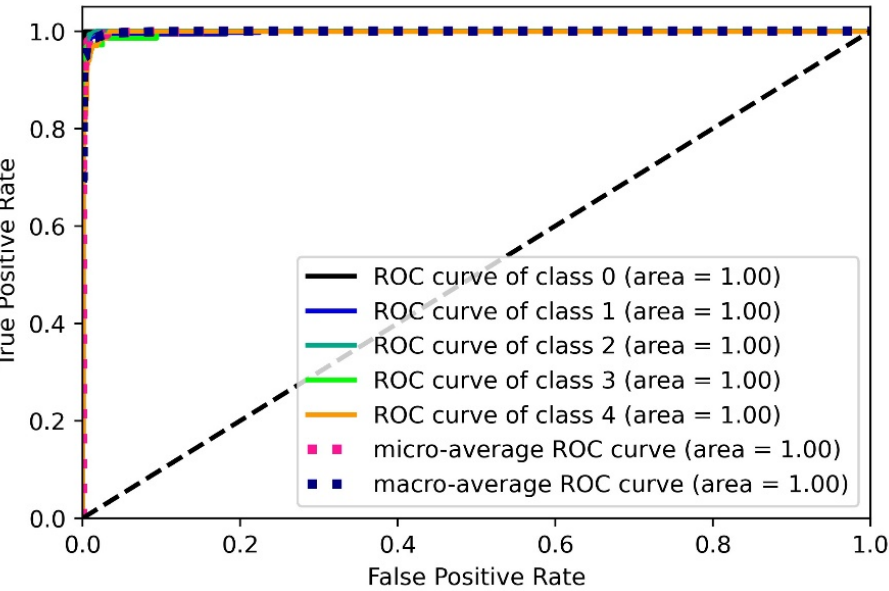
Figure 26. ROC and AUC for the Xception model. ( p < 0.0001; class 0: BP; class 1: COVID-19; class2: normal; class 3: TB; class 4: VP).